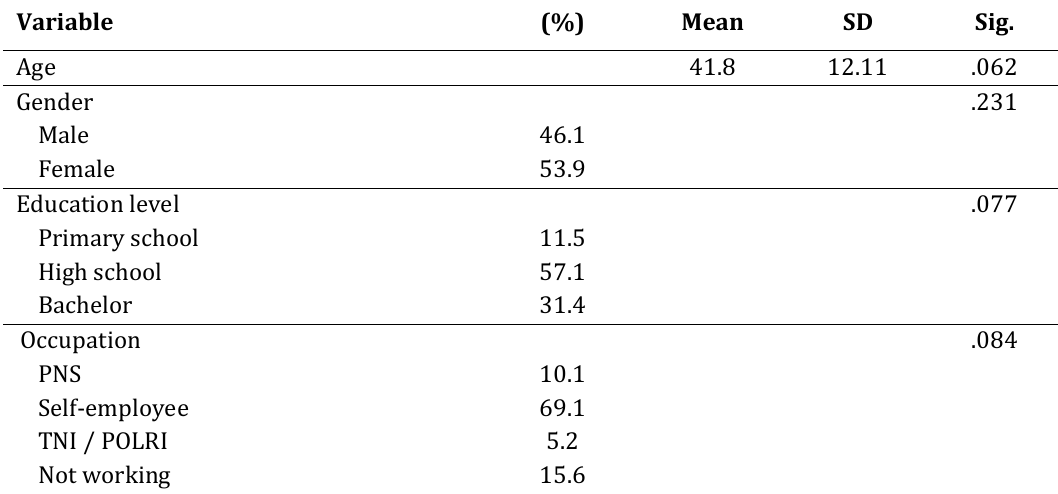
Characteristics of Respondents